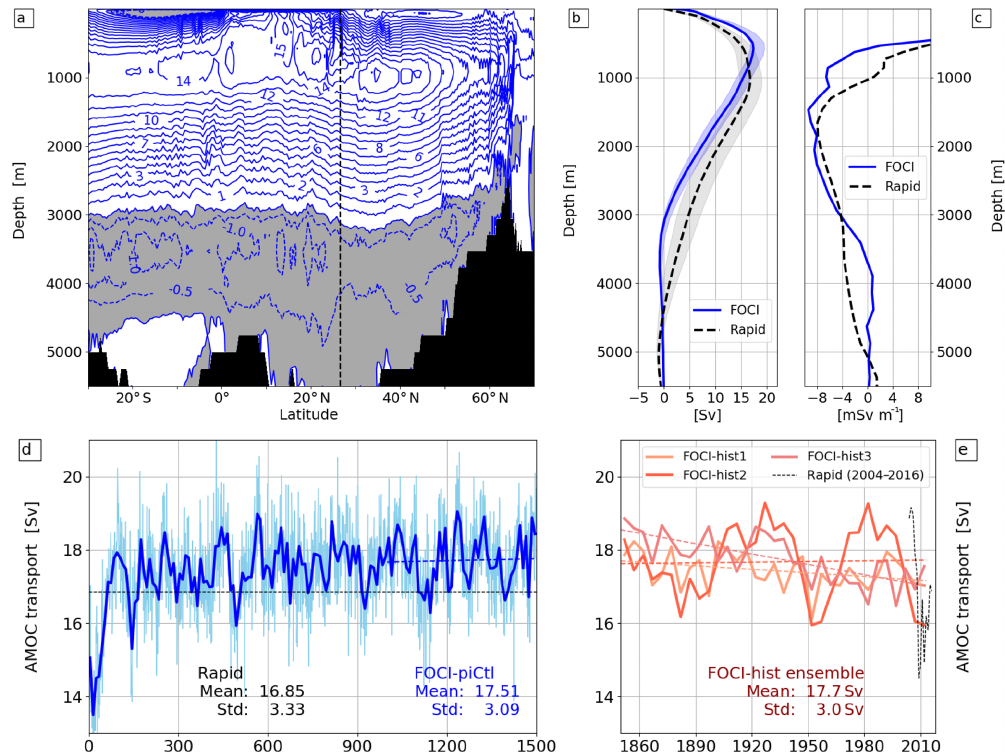
Figure 12. Atlantic meridional overturning stream function (in Sv, 500-year mean) as a (a) latitude–depth structure: shaded in grey are counterclockwise (confidence interval of 0.5Sv) cells; in white are clockwise (confidence interval of 1Sv) cells. (b) Vertical profile at 26.5 ◦ N. Provided in dashed black are observational values from the RAPID array; shaded envelopes represent the 5% and 95% quantiles of the annual profile time series. (c) Profile of the z derivative of AMOC at 26.5 ◦ N (in mSvm − 1 ). (d) Time series of maximum AMOC transport at 26.5 ◦ N in the upper 1500m (in Sv) as 10-year mean (blue) and annual mean (light blue) from FOCI-piCtl, dashed black line represents the mean over the observed 2004–2016 RAPID data; mean and standard deviations are based on monthly means, given at the bottom of panel (d) for RAPID (black, 2004–2016) and FOCI-piCtl (0–1500 years). (e) The 5-year mean time series from historical FOCI simulations (FOCI-hist[1,2,3], all orange), linear trends over the whole time period computed from annual means (dashed orange lines) and annual mean RAPID data (dashed black); mean strength and standard deviation calculated from monthly means of the ensemble mean are provided for the period